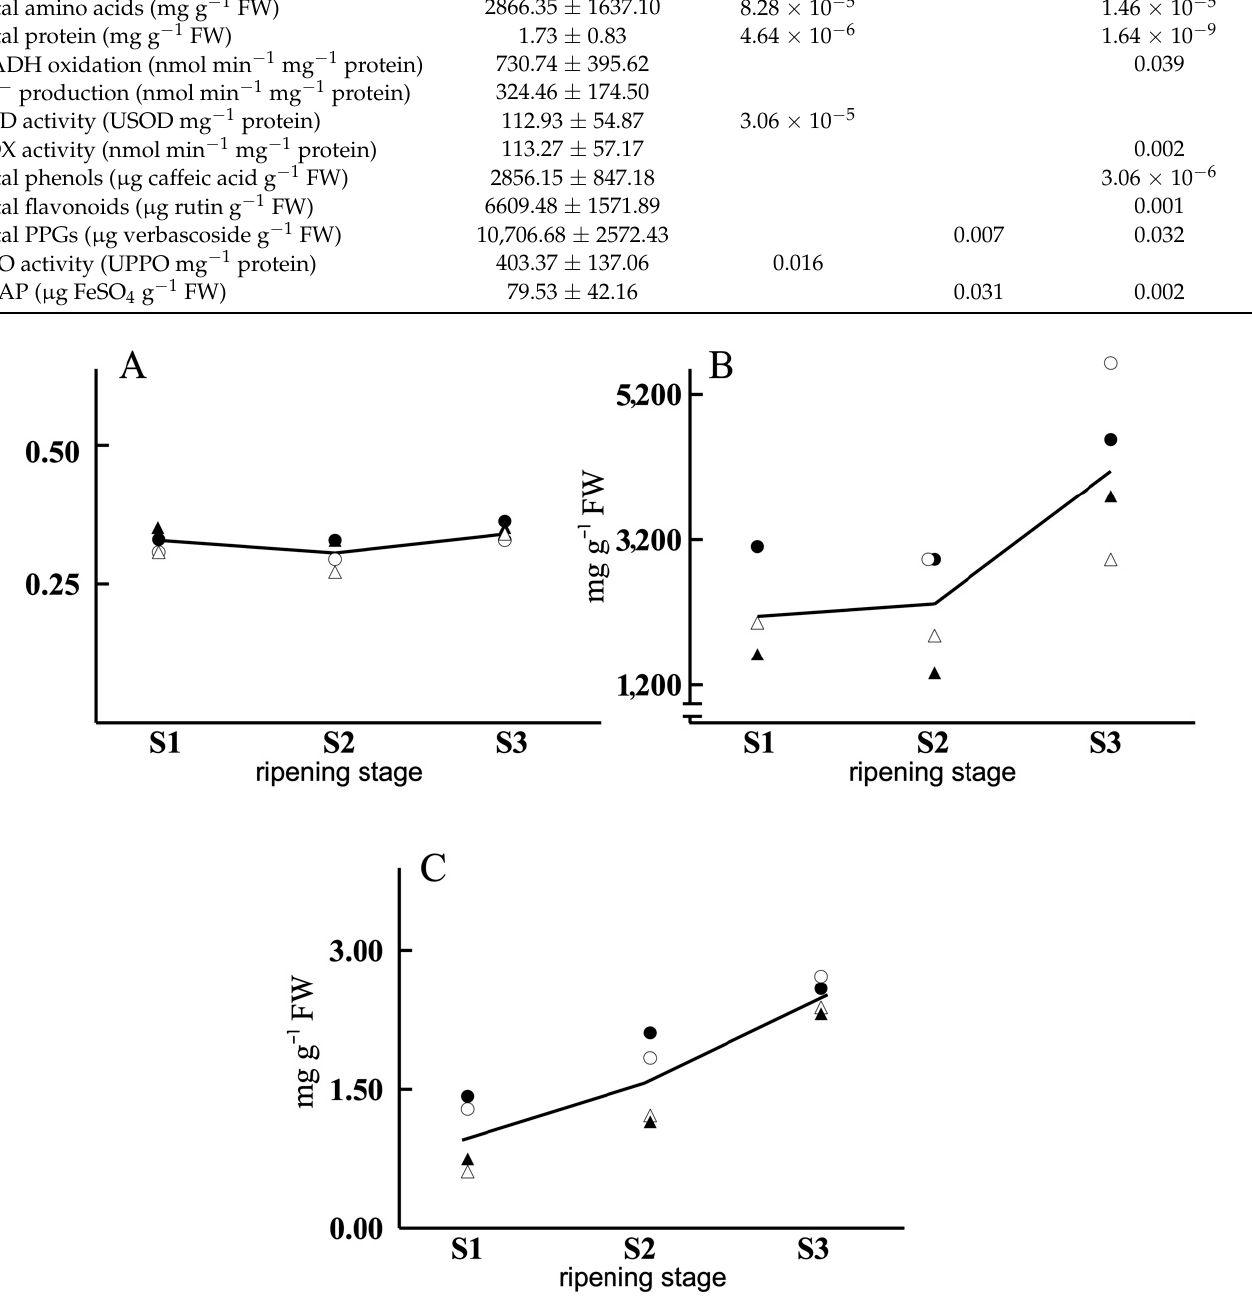
Figure 2. Line plots corresponding to DW/FW ( A ), total amino acids ( B ) and proteins ( C ) of olives of Morisca NI – ● –, Morisca FI – ○ –, Manzanilla NI – ▲ – and Manzanilla FI – △ –, for each ripening stage (derived from Table S3).